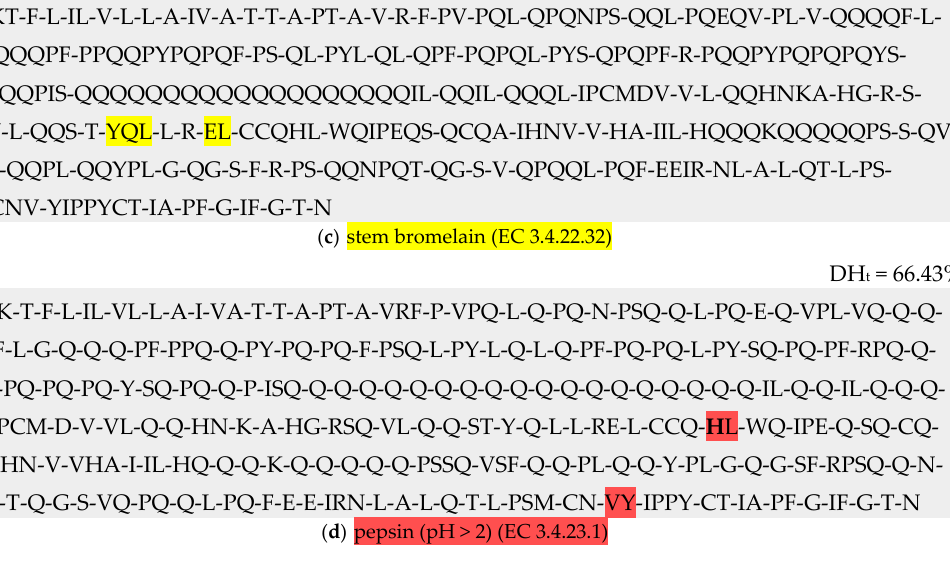
Figure 1. The amino acid sequence of α -gliadin (wheat, Triticum aestivum , ID 1304) containing selected fragments with antioxidative activity.